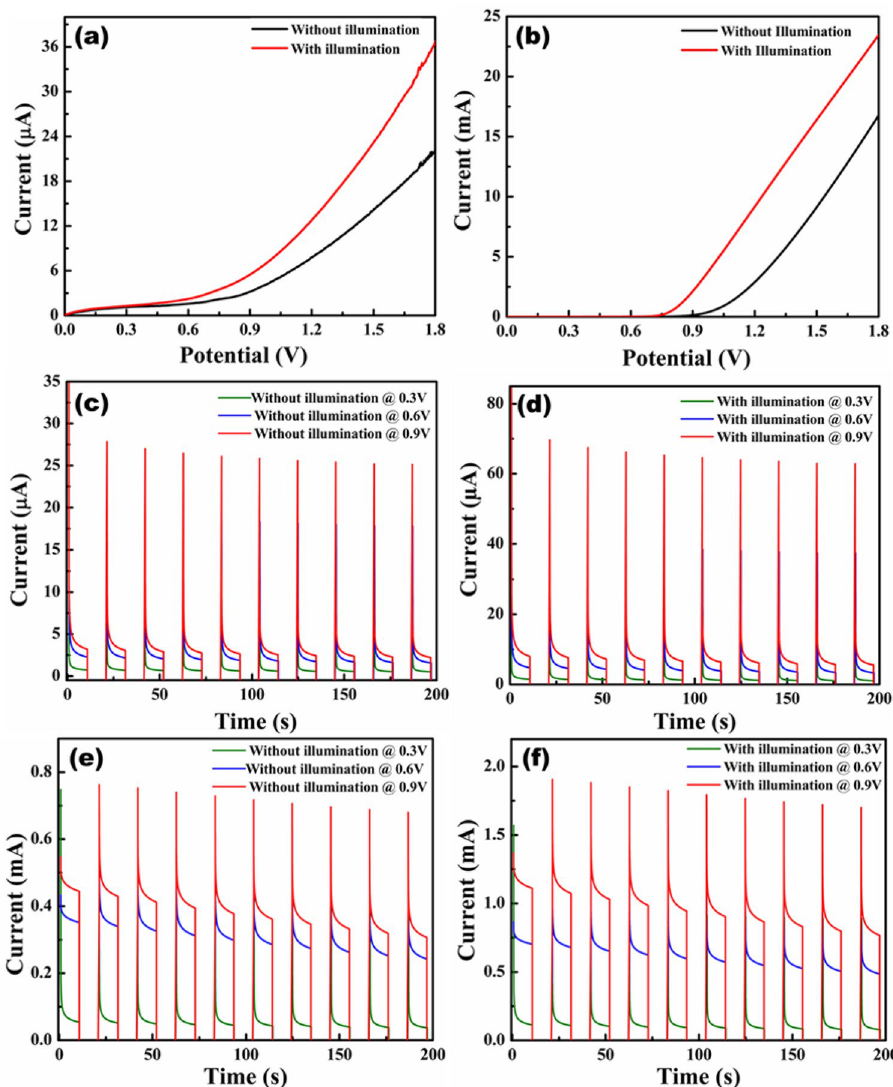
Figure 10. PEC characteristics of pure CFO and g-C 3 N 4 /CFO (CCN50) in 0.5 M KOH electrolyte under 100 mW/cm 2 light intensity ( a and b ) LSV curves of CFO and CCN50 with and without light. ( c and d ) CA plots of CFO with and without light. ( e and f ) CA plots of CCN50 with and without